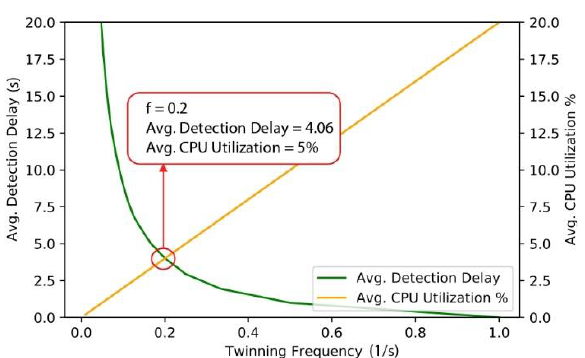
Figure 7. Average detection delay and CPU utilization